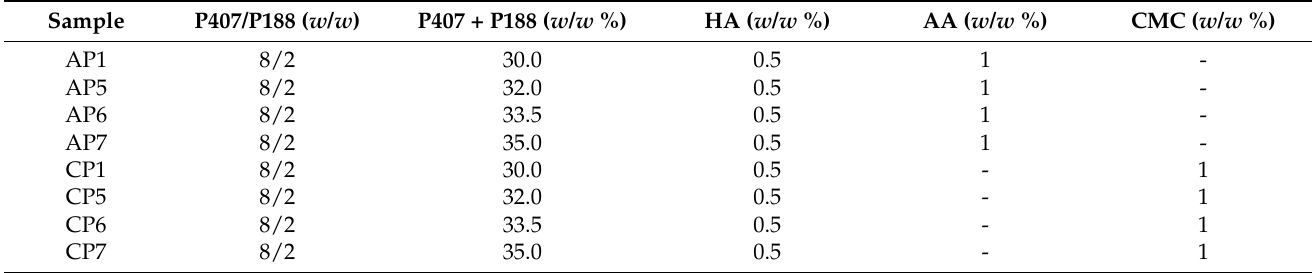
Table 4. Components in the formulation of P407-based hydrogel containing polysaccharides with different concentrations of poloxamers ( w / w % in 10 g saline).